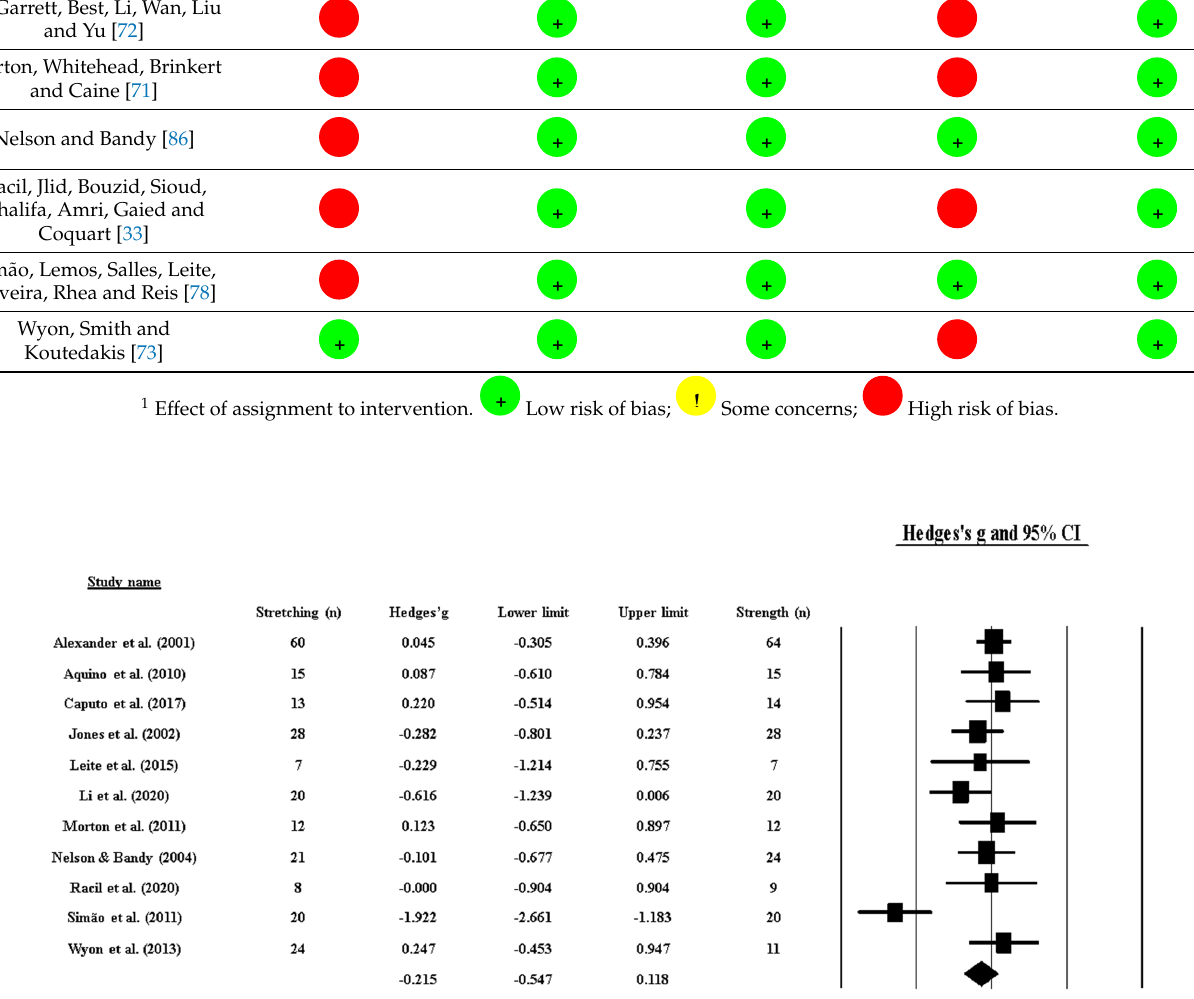
Table 2. Assessments of risk of bias (Cochrane’s RoB 2).